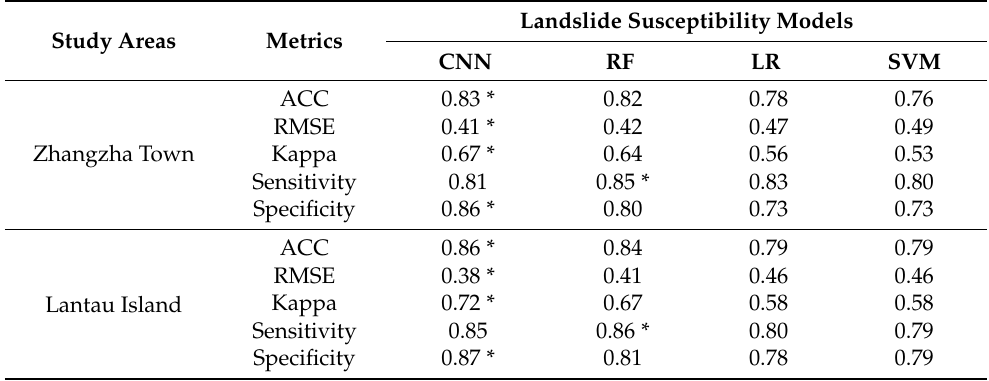
Table 3. Model evaluation and comparison on the testing